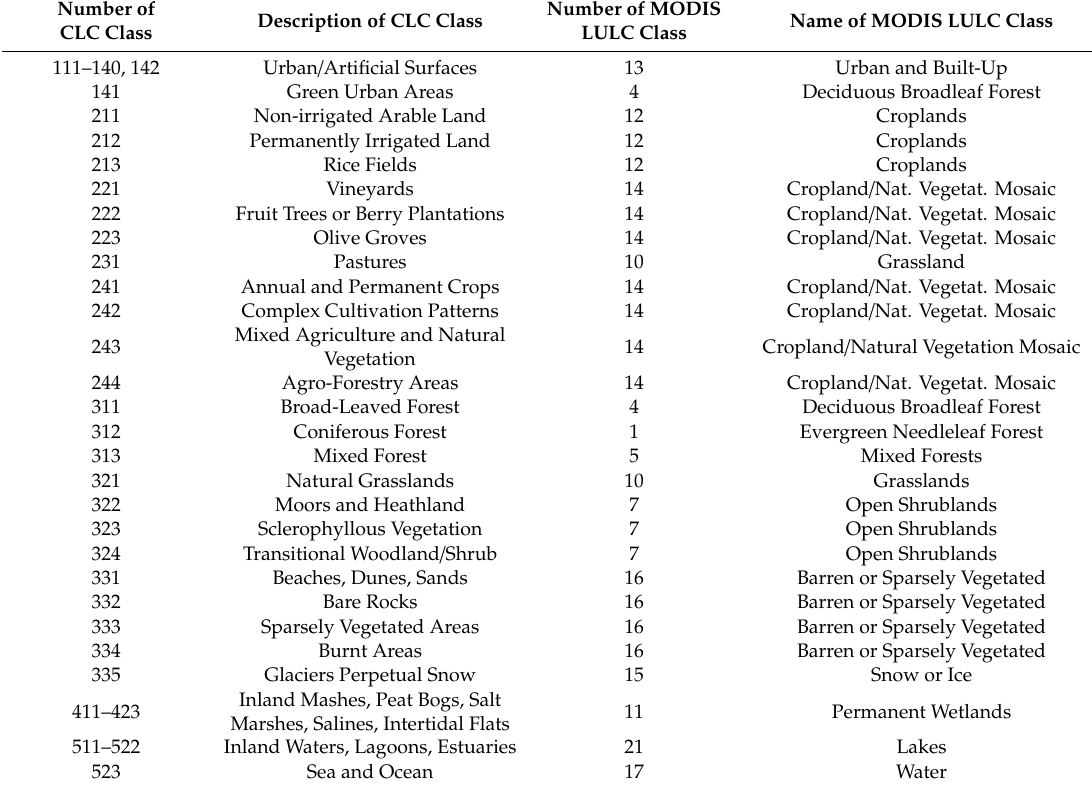
Table 3. Scheme of the reclassification for the LULC categories from the CLC to modified IGBP MODIS